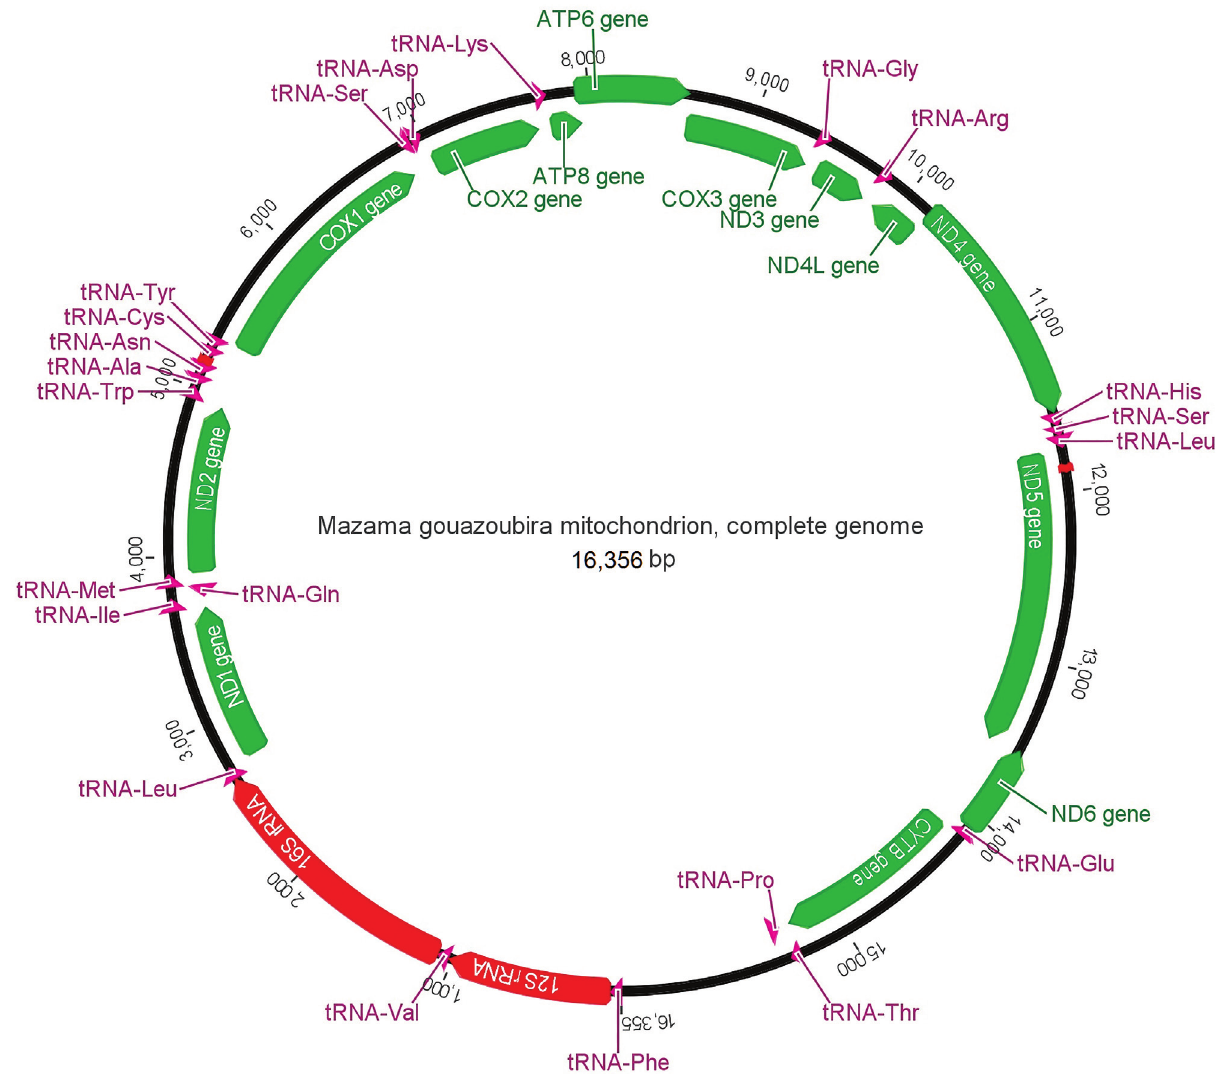
Figure 1 - Map of the brown brocket deer mitochondrial genome. ATP6-8: ATPase subunits 6 and 8, COX1-3: cytochrome c oxidase subunits I-III, CYTB: cytochrome b, ND1-6/4L: NADH dehydrogenase subunits 1-6/4L. All 22 transfer RNA genes are designated by tRNA-X. Arrowheads indicate the direction of transcription.